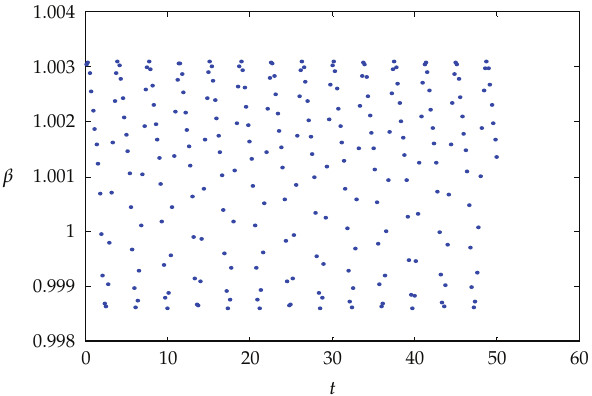
Figure 2: Value of parameter β (cid:2) time step (cid:9) 1.0s (cid:3)